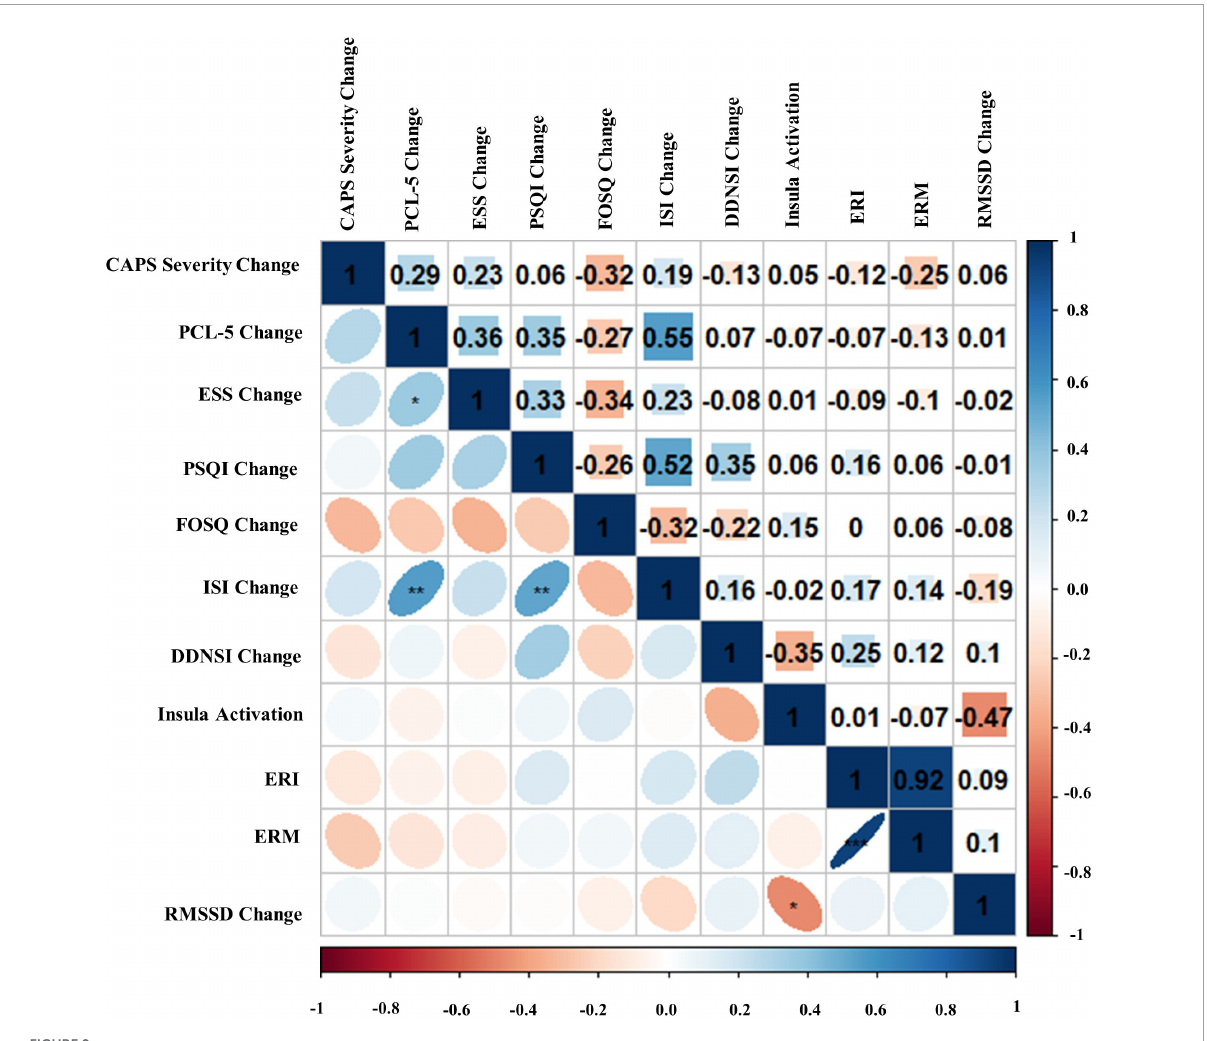
FIGURE9 Bivariate Pearson correlations were performed across Amber Light Treatment (ALT) subjects with correlation coefficients in the upper portion of the matrix and significant correlations identified in the lower portion of the matrix. Change represents residualized change scores. * p < 0.05, ** p < 0.01, *** p < 0.001. Clinician-Administered PTSD Scale for DSM-5 (CAPS-5), PTSD Checklist for DSM-5 (PCL-5), Epworth Sleepiness Scale (ESS), Pittsburgh Sleep Quality Index (PSQI), Functional Outcomes of Sleep Questionnaire (FOSQ), Insomnia Severity Index (ISI), Disturbing Dreams and Nightmares Severity Index (DDNSI), Extinction Recall Index (ERI), Extinction Recall Magnitude (ERM), Root Mean Square of Successive Differences (RMSSD).